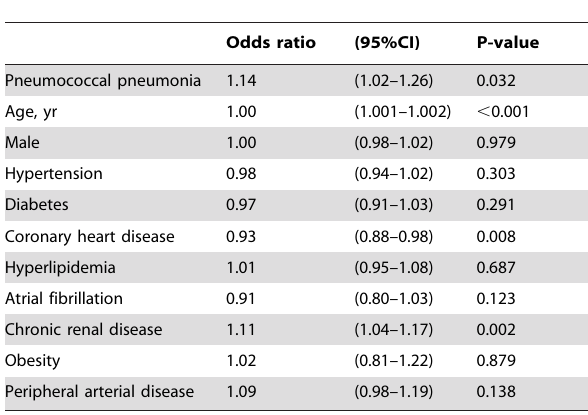
Table 6. Characteristics of individuals in high-pneumococcal pneumonia and low-pneumococcal pneumonia areas (n=1640).